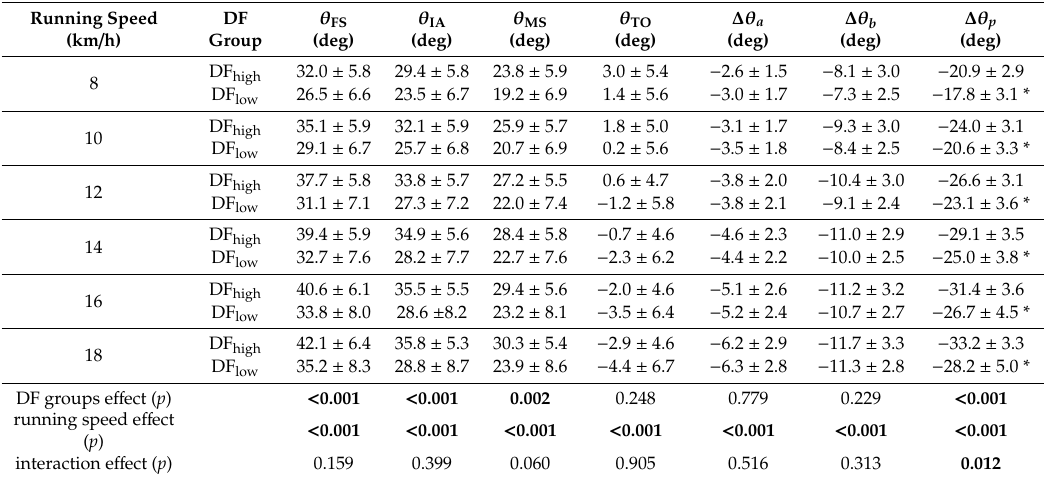
∆ θ ∆ θ a , p ) for the b , and